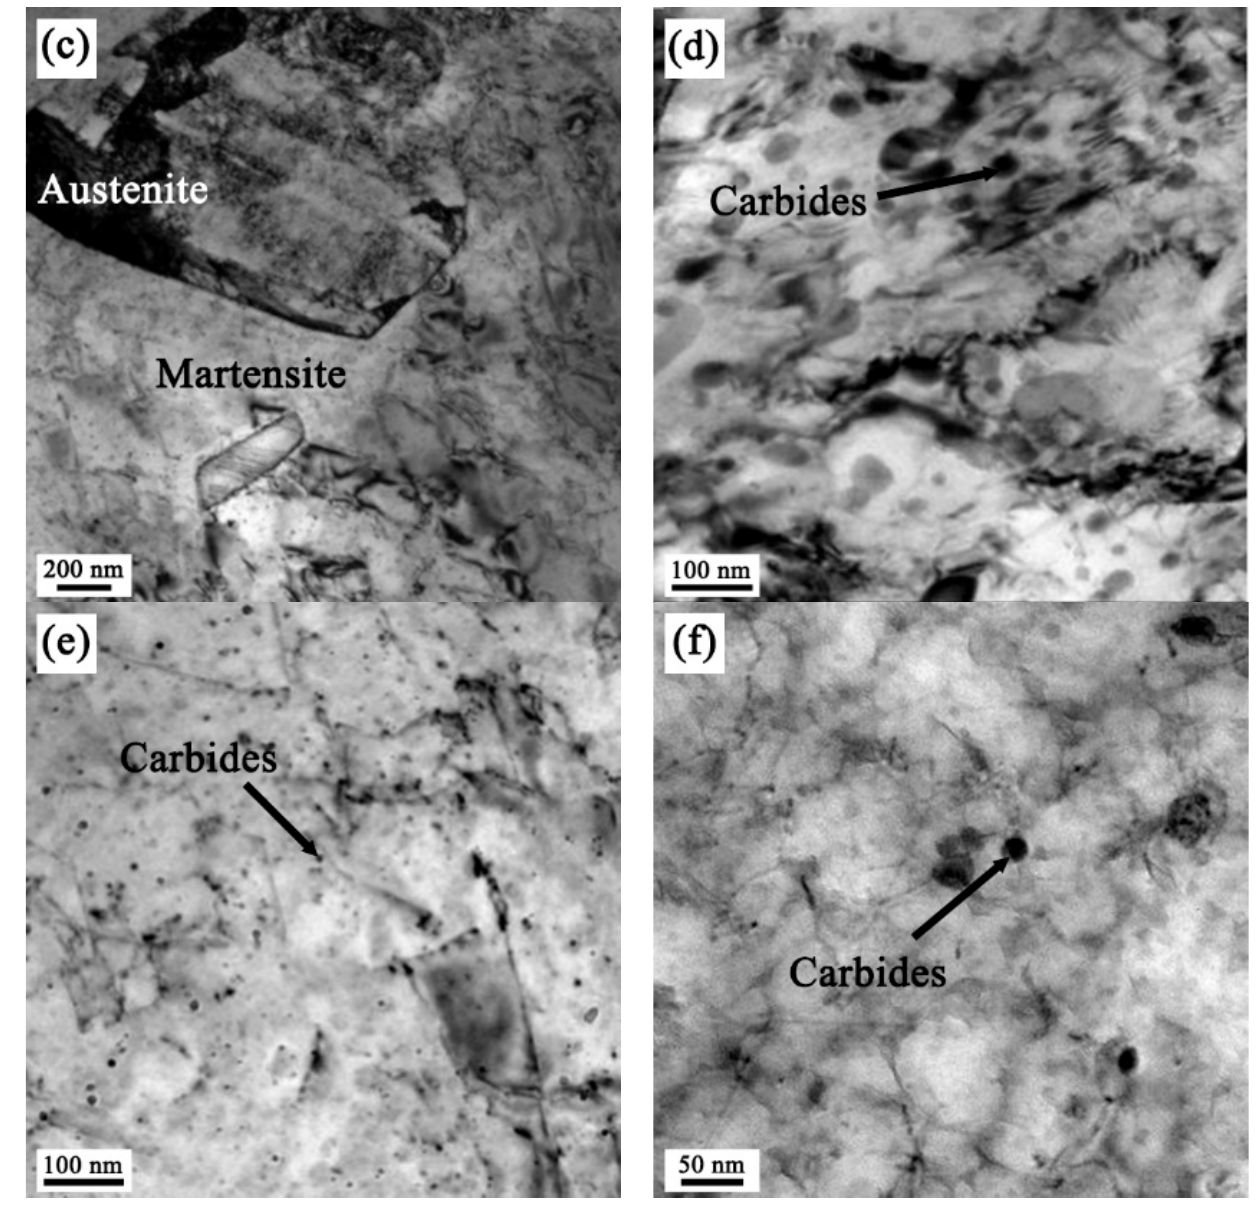
Figure 3. Morphology characteristics of retained austenite and carbides precipitated in the experi- mental steels: ( a – c ) RA in V-alloyed steel, Nb-Ti-alloyed steel, and Ti-alloyed steel, respectively. ( d – f ) Precipitation in V-alloyed steel, Nb-Ti-alloyed steel, and Ti-alloyed steel, respectively.